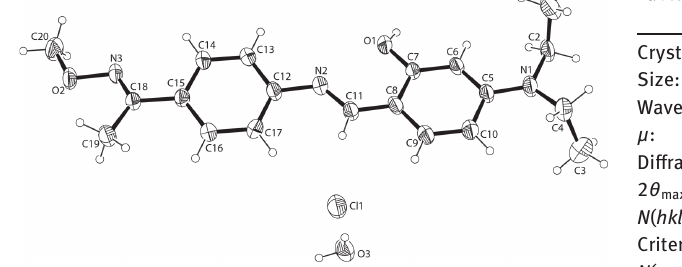
Table 1: Data collection and handling.